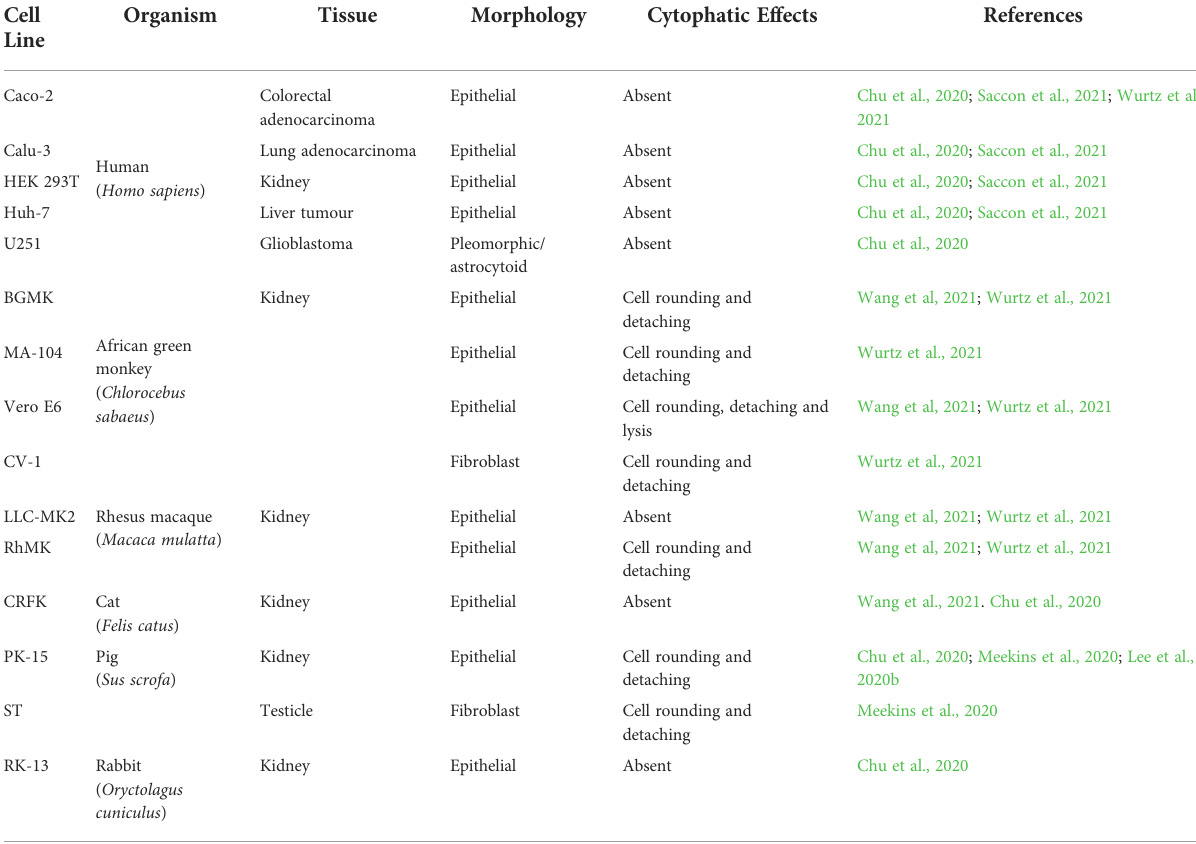
TABLE 1 SARS-CoV-2 permissive mammalian cells lines. Commonly used laboratory mammalian cell lines that can support SARS-CoV-2 replication with infective particles release at the end of the cycle. Cell